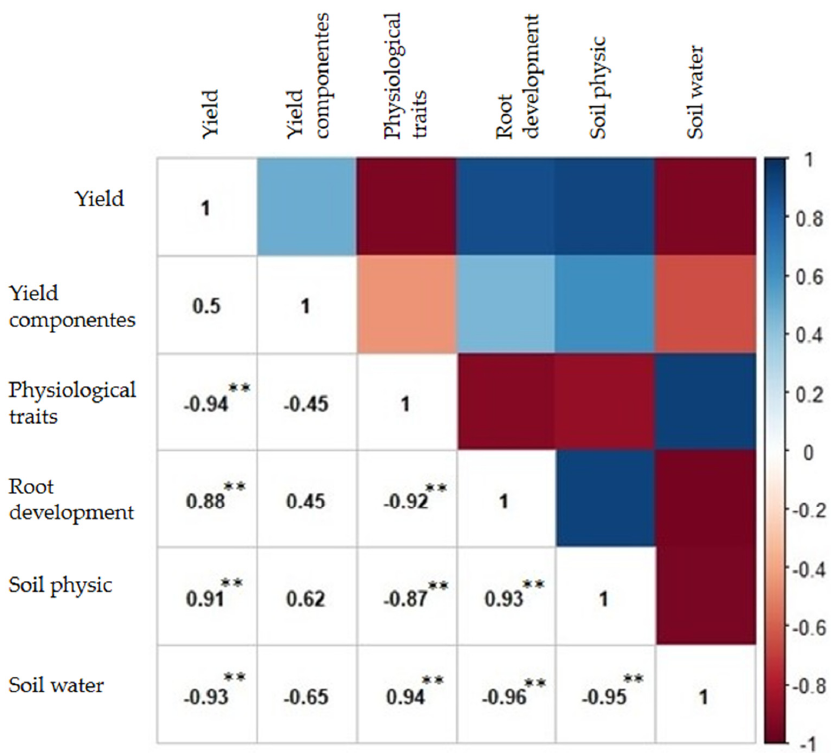
Figure 5. Pearson correlation between first principal component of each variable group. ** significant correlation at p < 0.01.